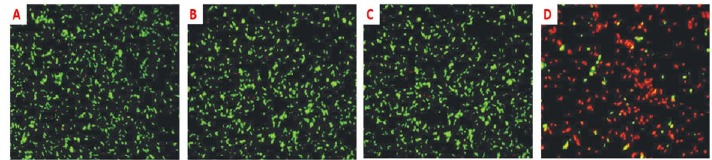
Figure 8. Viability of Pseudomonas aeruginosa cells with attached gold nanorods following exposure to near-infrared (NIR) light. Left panels: ( A ) Cells without nanorods exposed to NIR; ( B ) Cells with nanorods and no NIR exposure; ( C ) ( D ) Cells with nanorods and exposed to NIR for 10 mins. Cells were stained with SYTO 9 and propidium iodide and imaged at 400 × magnification using a fluorescence microscope. Green fluorescent cells are representative of live cells while red fluorescent cells are representative of dead or compromised cells. [67]. Reprinted with permission from ref. [67]. Copyright 2011 Wiley Interdisciplinary Reviews—Nanomedicine and Nanobiotechnology.